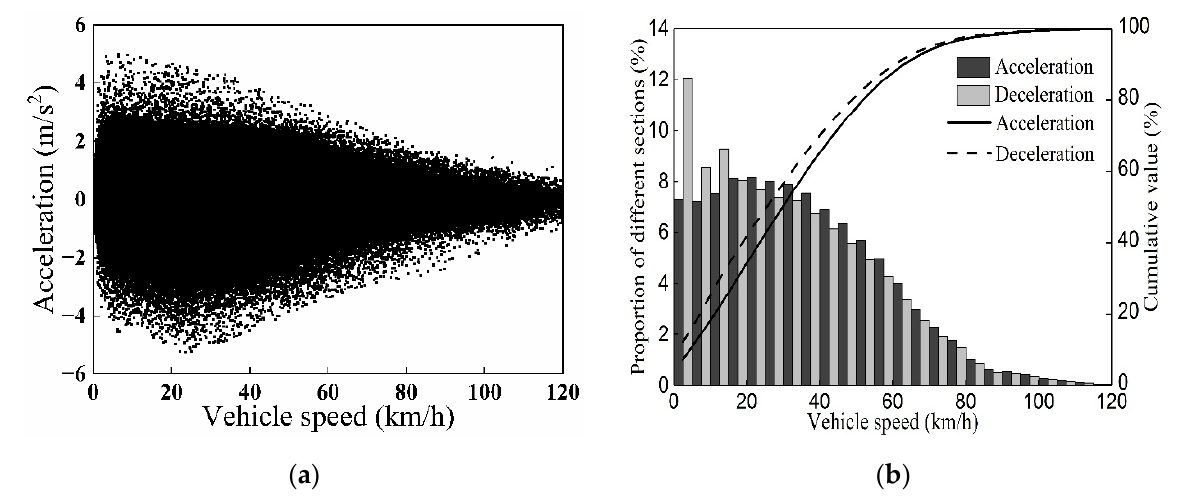
Figure 10. The distribution characteristic of acceleration and deceleration versus vehicle speed: ( a ) Overall trend; ( b ) Comparison of distribution characteristic.